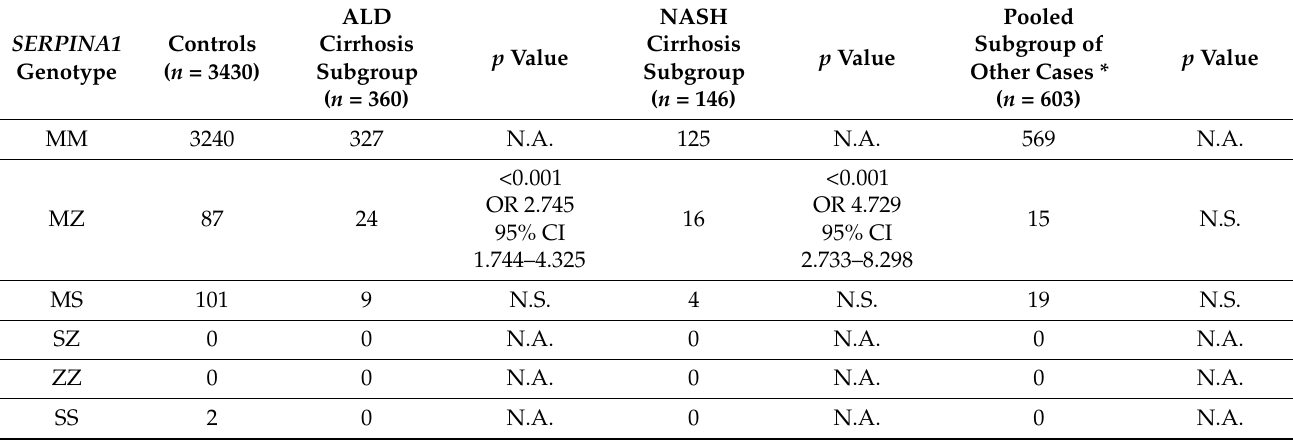
Table 2. SERPINA1 genotype distribution according to the aetiology of liver cirrhosis in comparison with the control group.